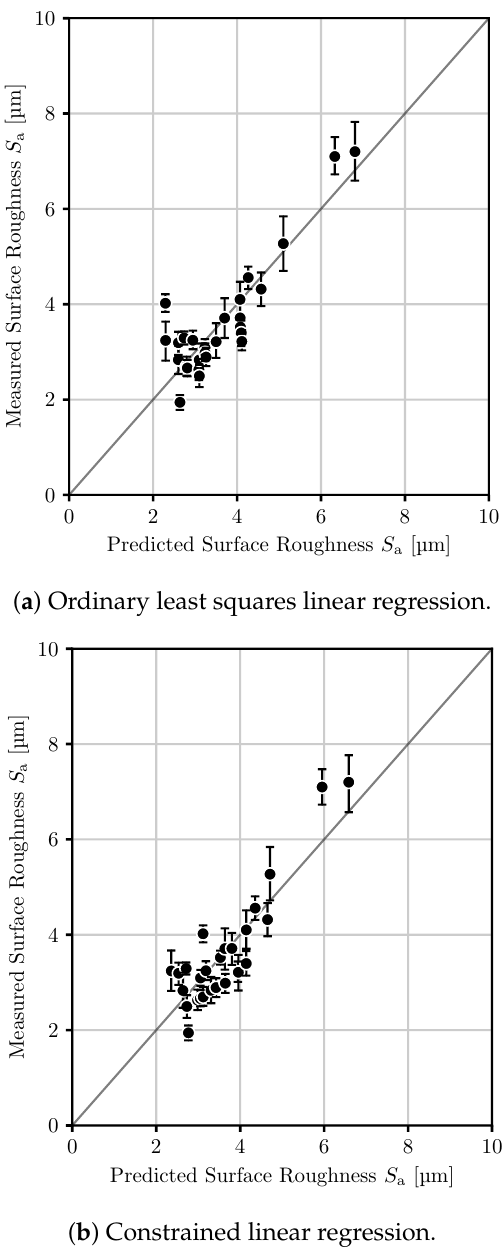
Figure 18. Parity plots for the mapping between tracked quantities and arithmetic mean surface roughness S a